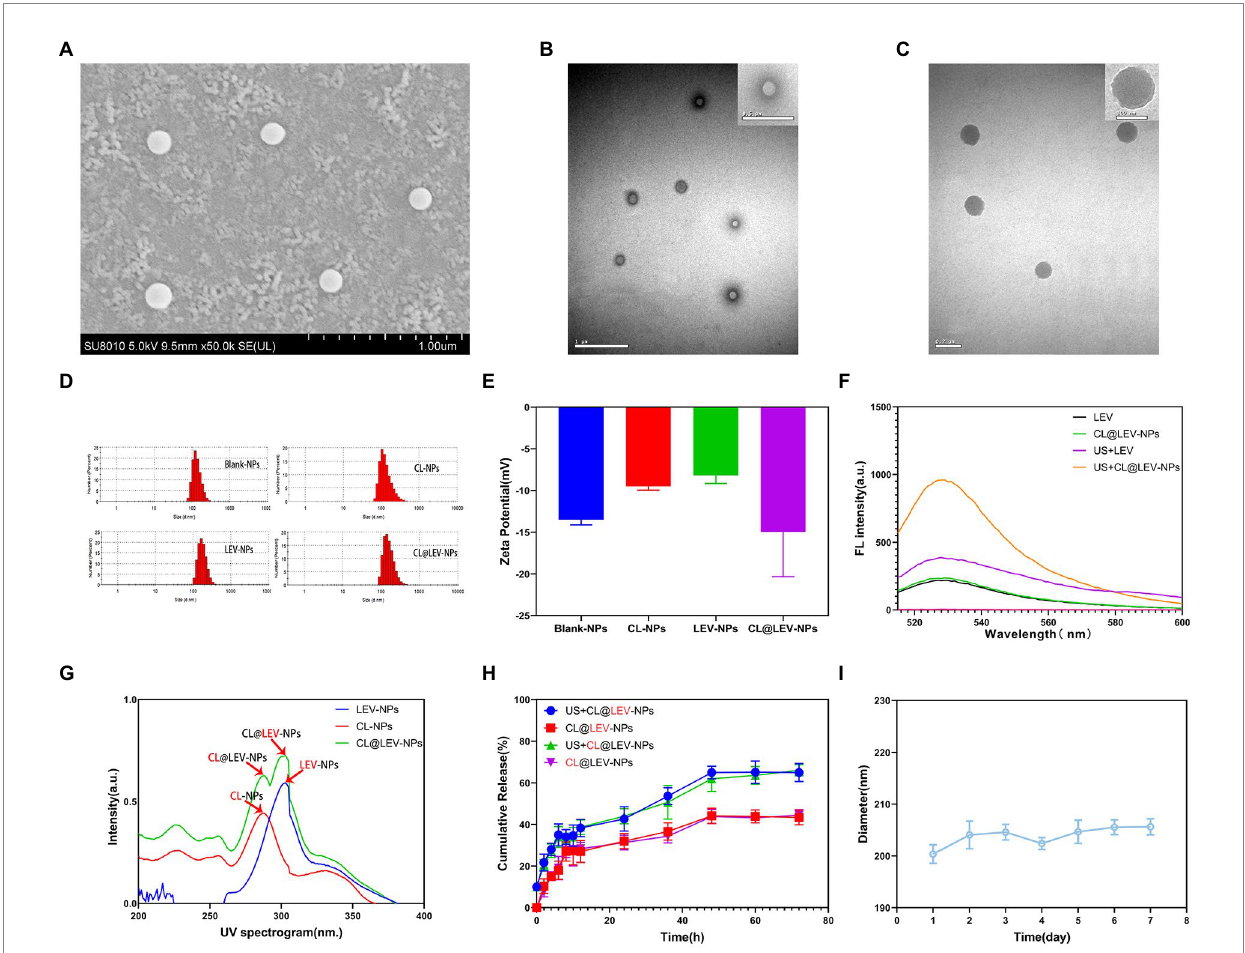
FIGURE 4 Basic properties of nanoparticles. (A) SEM observation of CL@LEV-NPs (SEM × 50 k); (B) TEM observation of Blank-NPs (TEM × 20 k OR ×40 k); (C) TEM observation of CL@LEV-NPs (TEM × 50 k OR ×120 k); (D) Particle size distribution of different nanoparticles; (E) Zeta potential of different nanoparticles; (F) SOSG detection of singlet oxygen of different drugs; (G) UV spectra of different drug-loaded nanoparticles; (H) Release profiles of two drugs from nanoparticles (CL@LEV-NPs) with or without ultrasound irradiation (0–72 h). (I) Particle size variation of CL@LEV-NPs dispersed in PBS with time extension ( n =